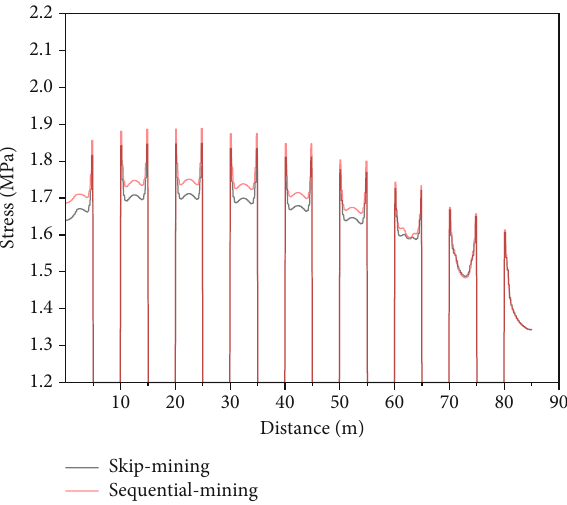
Figure 7: Distance-stress curve of two excavation methods. Figure 6: Maximum unbalance stress curve of two excavation